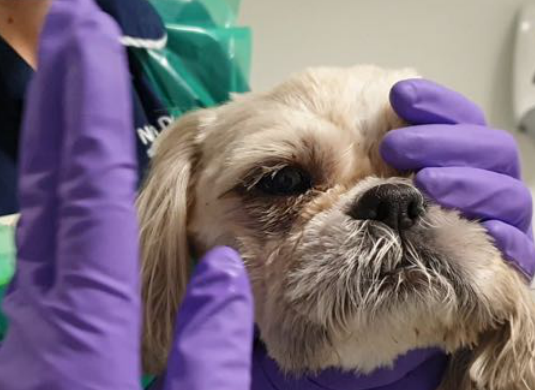
Figure 9. Evaluation of the menace response- note the contralateral eye should be covered during the assessment (North Downs Specialist Referrals)